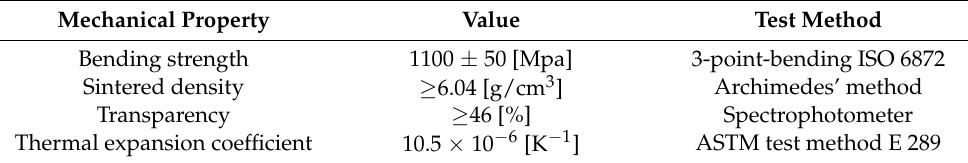
Table 3. Mechanical properties of the zirconia block.